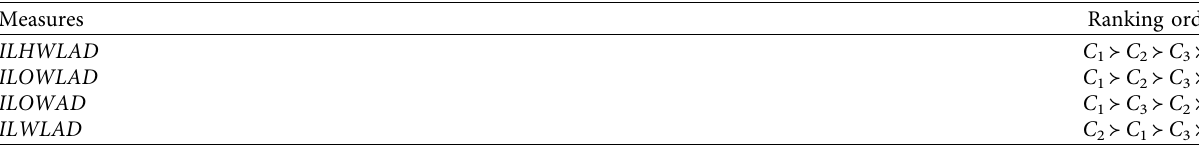
Table 11: The ranking orders of different